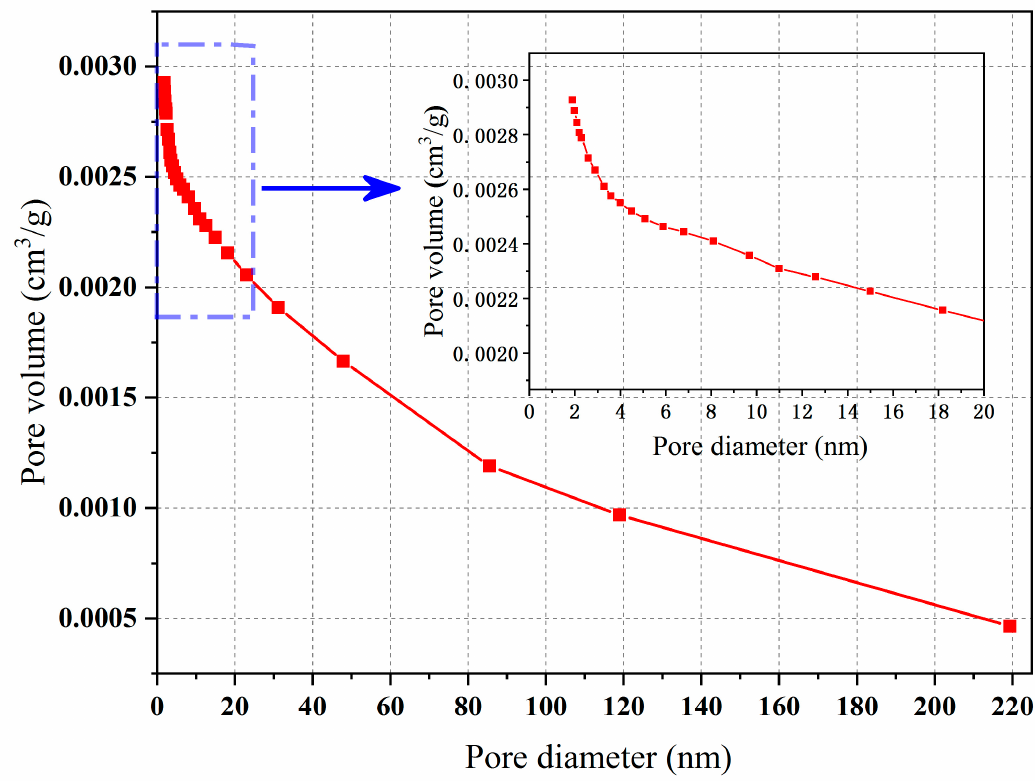
Figure 5. Pore size distribution of ceramsite.